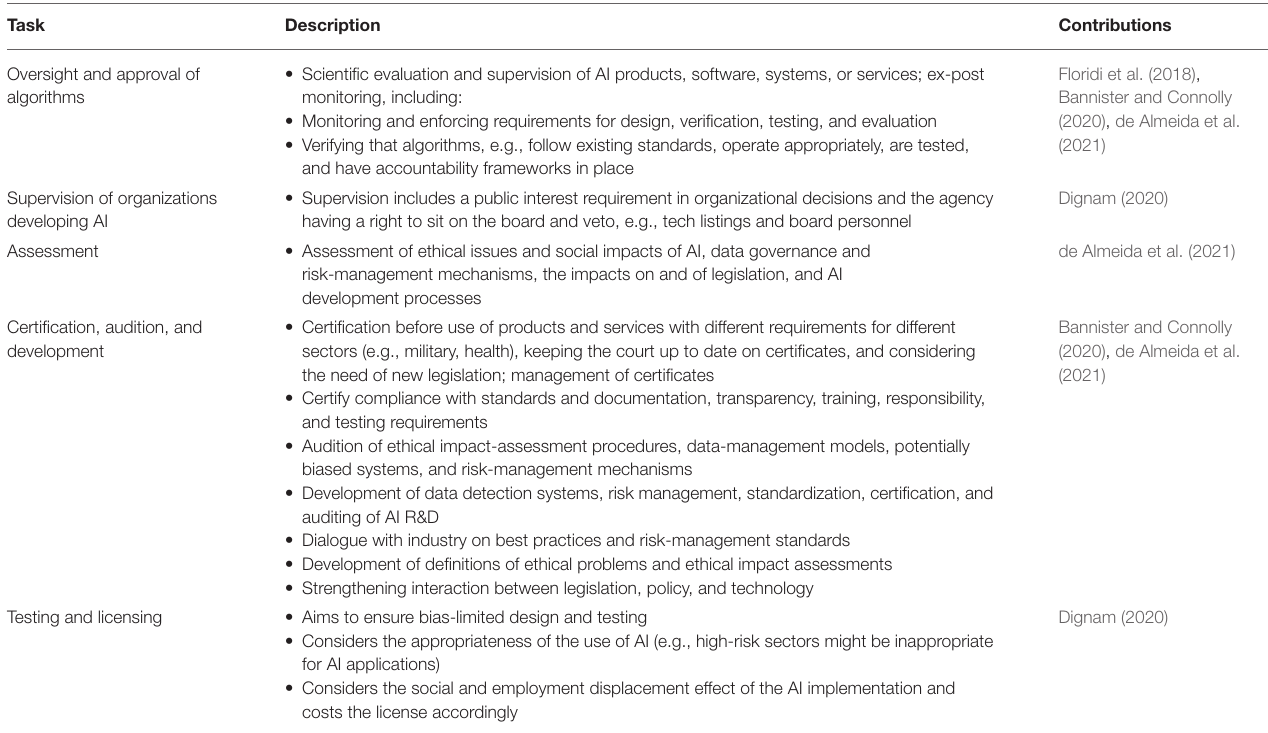
TABLE 5 | Tasks of AI governance